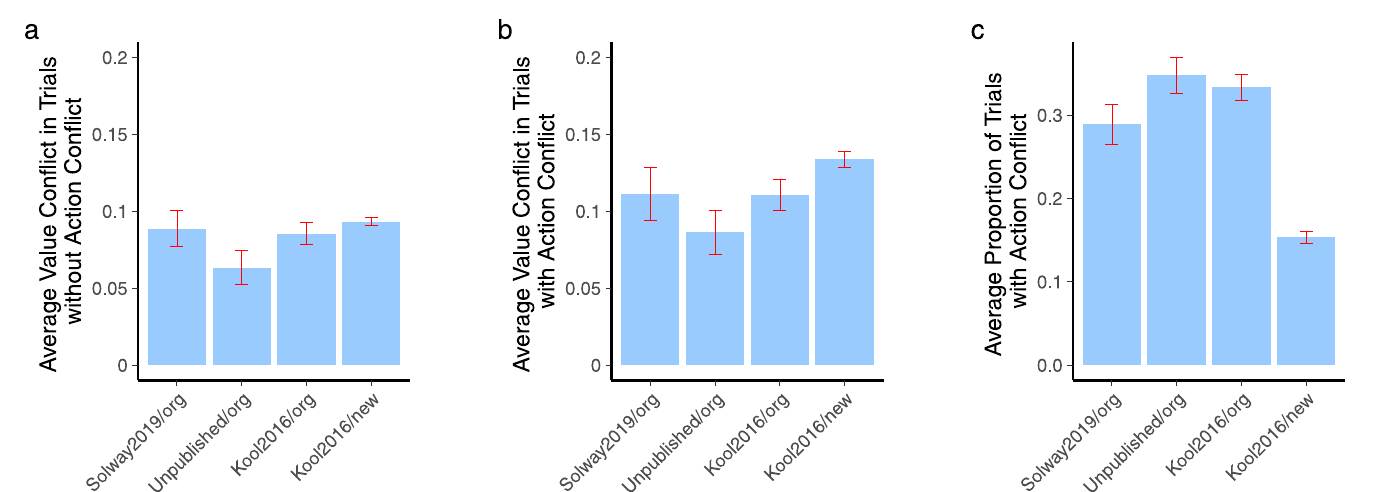
Fig 3. A. Average value conflict for trials without action conflict. Note that the values for the newer task version (Kool2016/new task) were normalized to put them on the same scale as the original task version. See Methods. B. Average value conflict for trials with action conflict. C. Average proportion of trials with action conflict.